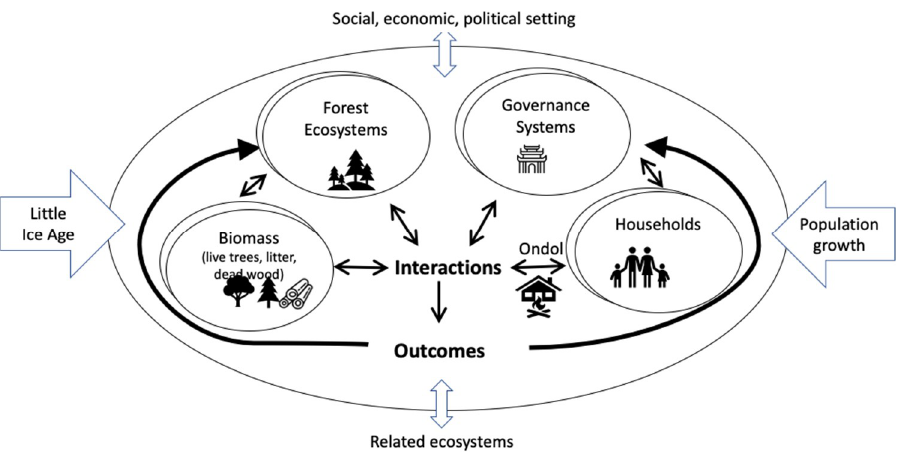
Figure 1. The late Joseon period as a social-ecological system (SES) with four core subsystems: (1) forest ecosystems within Joseon’s territory as Resource Systems, (2) forest biomass for fuel as Resource Units, (3) Joseon’s governing structure and formal and informal rules as Governance Systems, and (4) households as Actors.